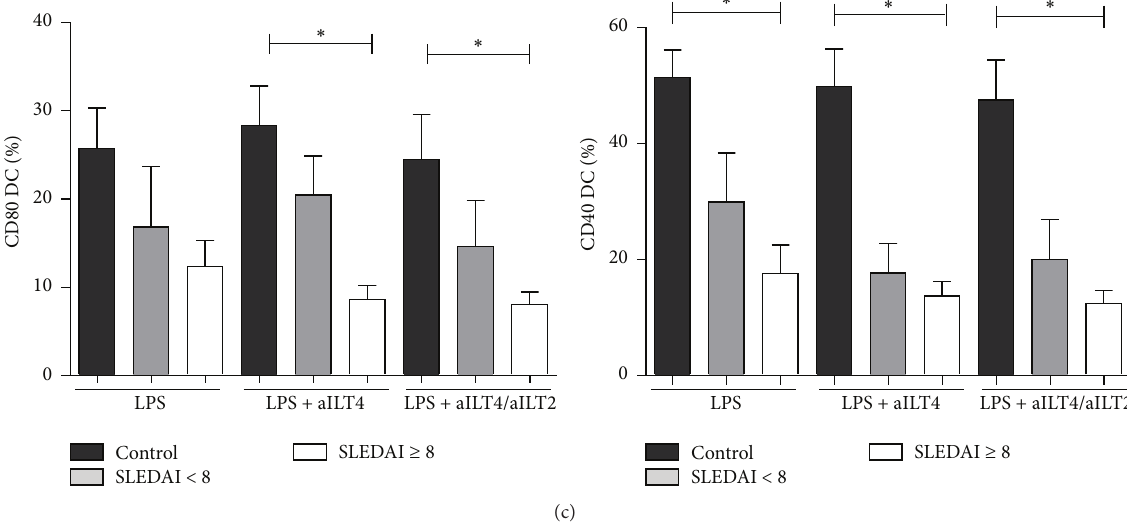
Figure 2: Expression of costimulatory molecules in mature monocyte-derived DC (moDC) from healthy controls compared to SLE patients. MonocytesfromSLEpatientsandhealthycontrolswereinducedtodifferentiateintoDCwithGM-CSF/IL-4andthenculturedinthepresence of LPS in the presence or absence of anti-ILT4 and/or anti-ILT2 agonistics mAbs (aILT4/ILT2). DC were immunostained for CD11c, HLA-DR, CD83, CD80, CD86, and CD40 and analyzed by flow cytometry. (a) CD11c and HLA-DR expression on immature and mature moDC from SLE patients (A). Percentages and MFI of CD83 expression on moDC from SLE patients and healthy controls are shown ((B) and (C)). (b) Data from SLE patients and healthy controls is shown. CD80 and CD40 expression was measured as the percentage of positive cells. CD86 expression was assessed as the mean fluorescence intensity (MFI). (c) Results from SLE patients were grouped according to SLEDAI index score ( < 8 and ≥ 8) and compared to healthy controls. ∗ 𝑝 < 0.05 , ∗∗ 𝑝 < 0.01 , and ∗∗∗ 𝑝 < 0.001 .